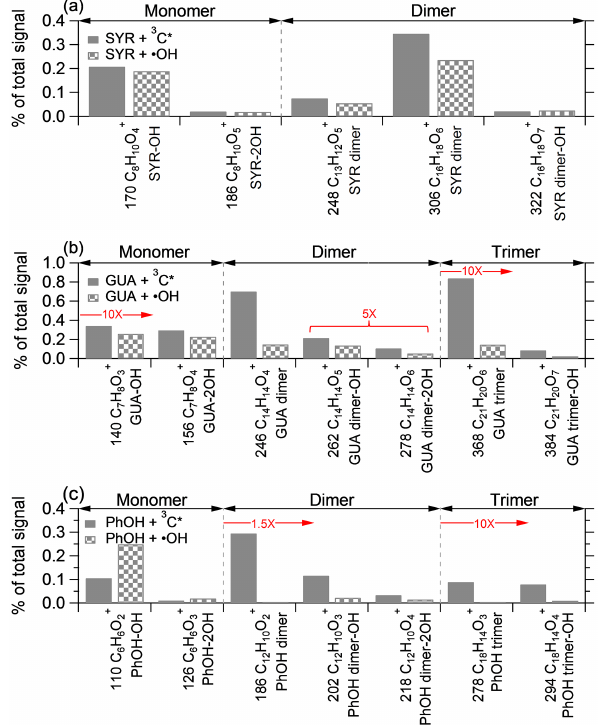
Figure 8. Comparisons of the relative abundances of signature ions in the AMS spectra of the aqSOA of (a) syringol (SYR), (b) guaia- col (GUA), and (c) phenol (PhOH) produced from 3 C ∗ -mediated and · OH-mediated reactions. The signal contributions of certain signature ions are enhanced for clarity. The m/z values of the signa- ture ions are shown in front of the ion formula in the x axes. Iden- tities of possible parent compounds are shown to the right. 2OH represents two additional hydroxyl groups attached to the aromatic ring.